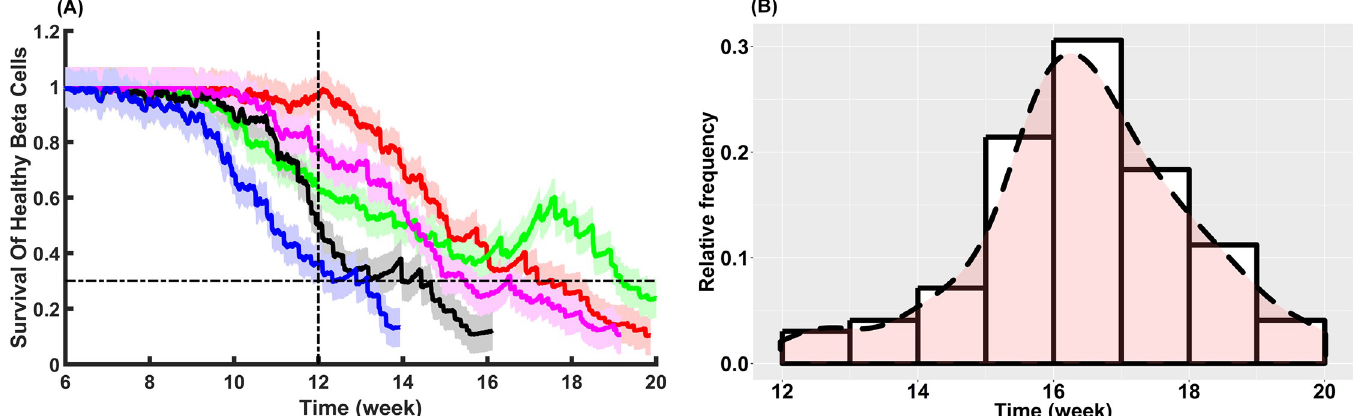
Fig 5. Validation of the ABM model using experimental findings. (A) Survival of healthy β cells during individual-specific T1D progression. Five solid lines represent the enduring fraction of healthy β cells in 100 distinct simulation runs with the same initial setting ( n = 20 and mean i ± SEM i , for i 2 {1: Blue, 2: Black, 3: Green, 4: i Magenta, 5: Red}; parameter values can be found in S1 and S5 Tables ). The vertical dotted-dashed line represents week 12 after the simulation initialization. The horizontal dotted-dashed line ( y = 0.3) denotes the remaining 30% of healthy β cells, about which overt T1D may occur. (B) Distribution of overt T1D development occurring during week 12 and week 20 in 100 simulation runs corroborating experimental data [45,73,74].The horizontal axis represents the time required for developing overt T1D in-silico, and the vertical axis denotes the relative frequency of T1D incidence. It is important to note that T1D onset occurs in our simulations based on the assumption that the survival percentage of healthy β cells falls randomly within the range of 10% - 30% of the initial healthy β cells (the total number of β cells at the simulation step 0).